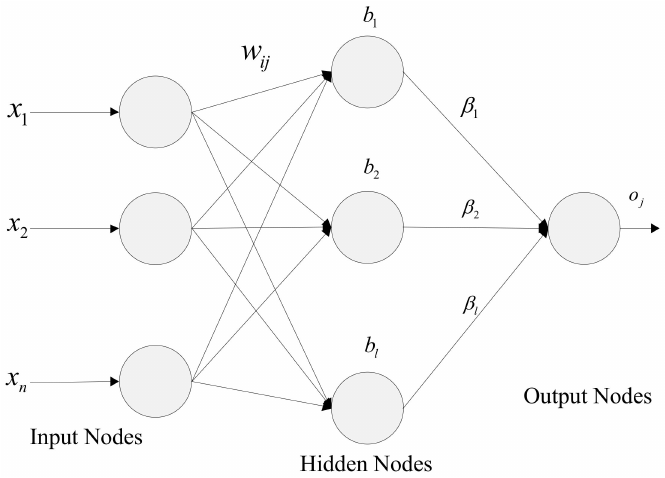
Figure 1. ELM structure